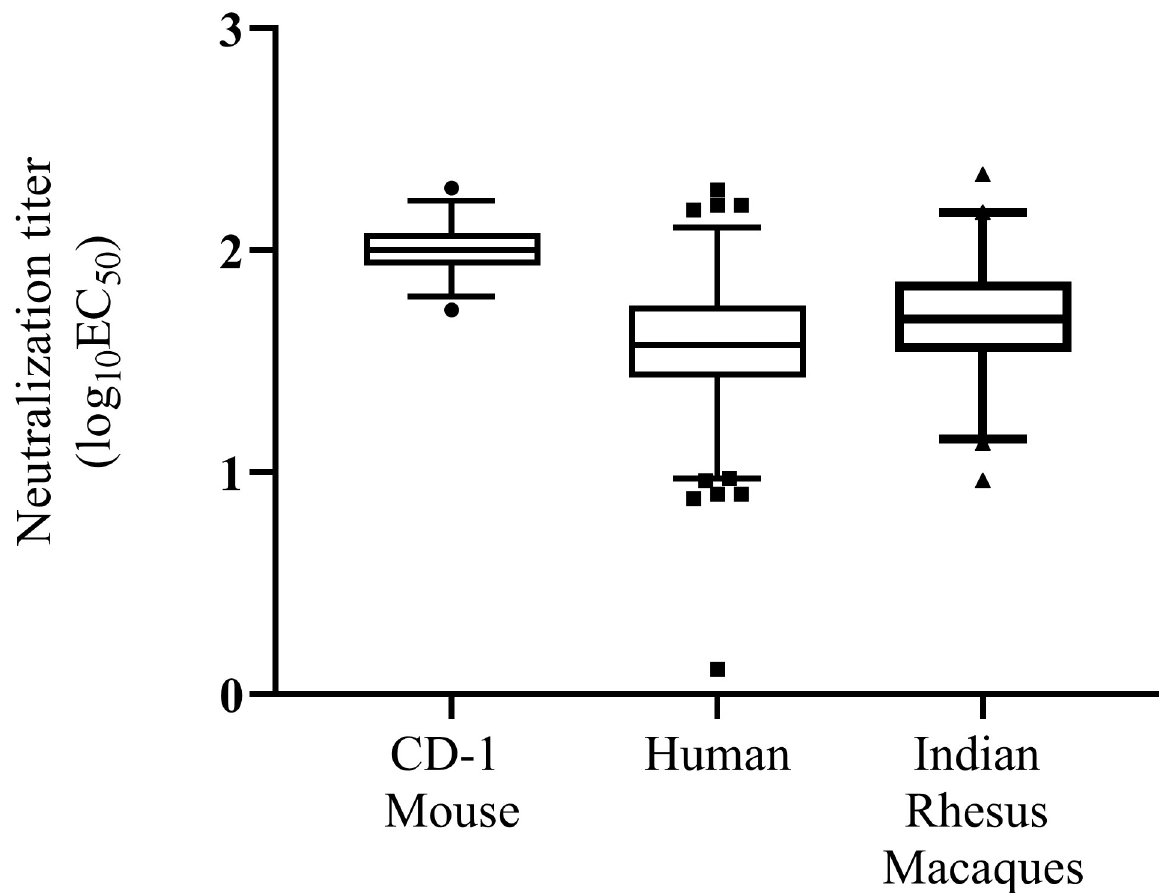
Fig 7. Matrix effect on the Z-RVP-384 assay by species. Quantile plots of log 10 EC 50 values are shown for 124 human, 84 rhesus macaque, and 69 CD-1 mouse sera. Titers below 1.5 log 10 are extrapolated (only included for demonstration), and should be reported as < LOD/LLOQ.